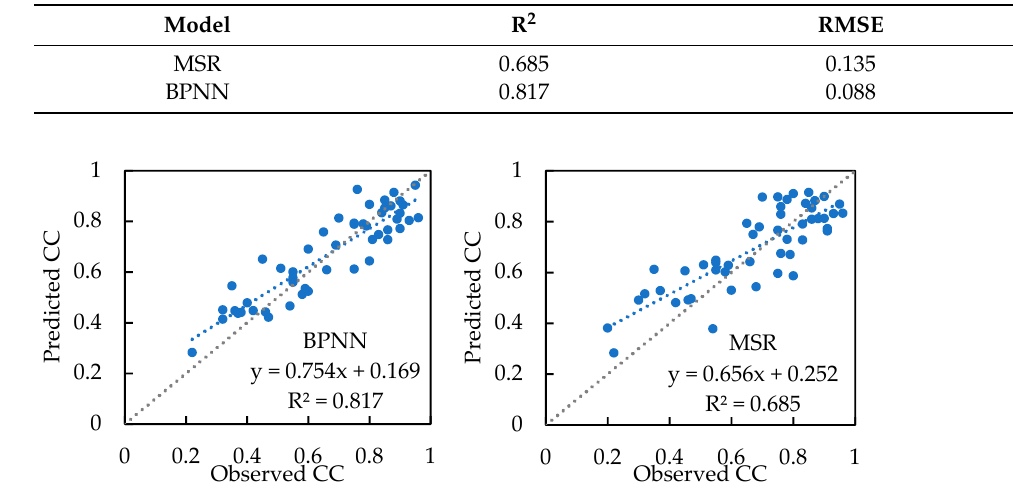
Table 16. Input parameters of the Li–Strahler GO model used to analyze a single scene